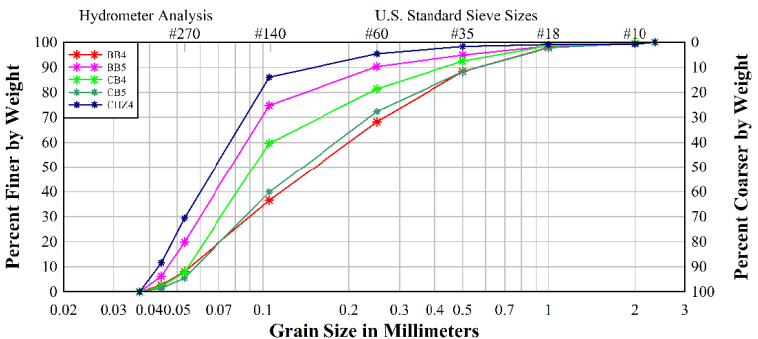
Figure 8. Soil grain size distribution within the confluence, showing a fining of sand from upstream (BB and CB sites) to downstream into the confluence zone (CHZ).